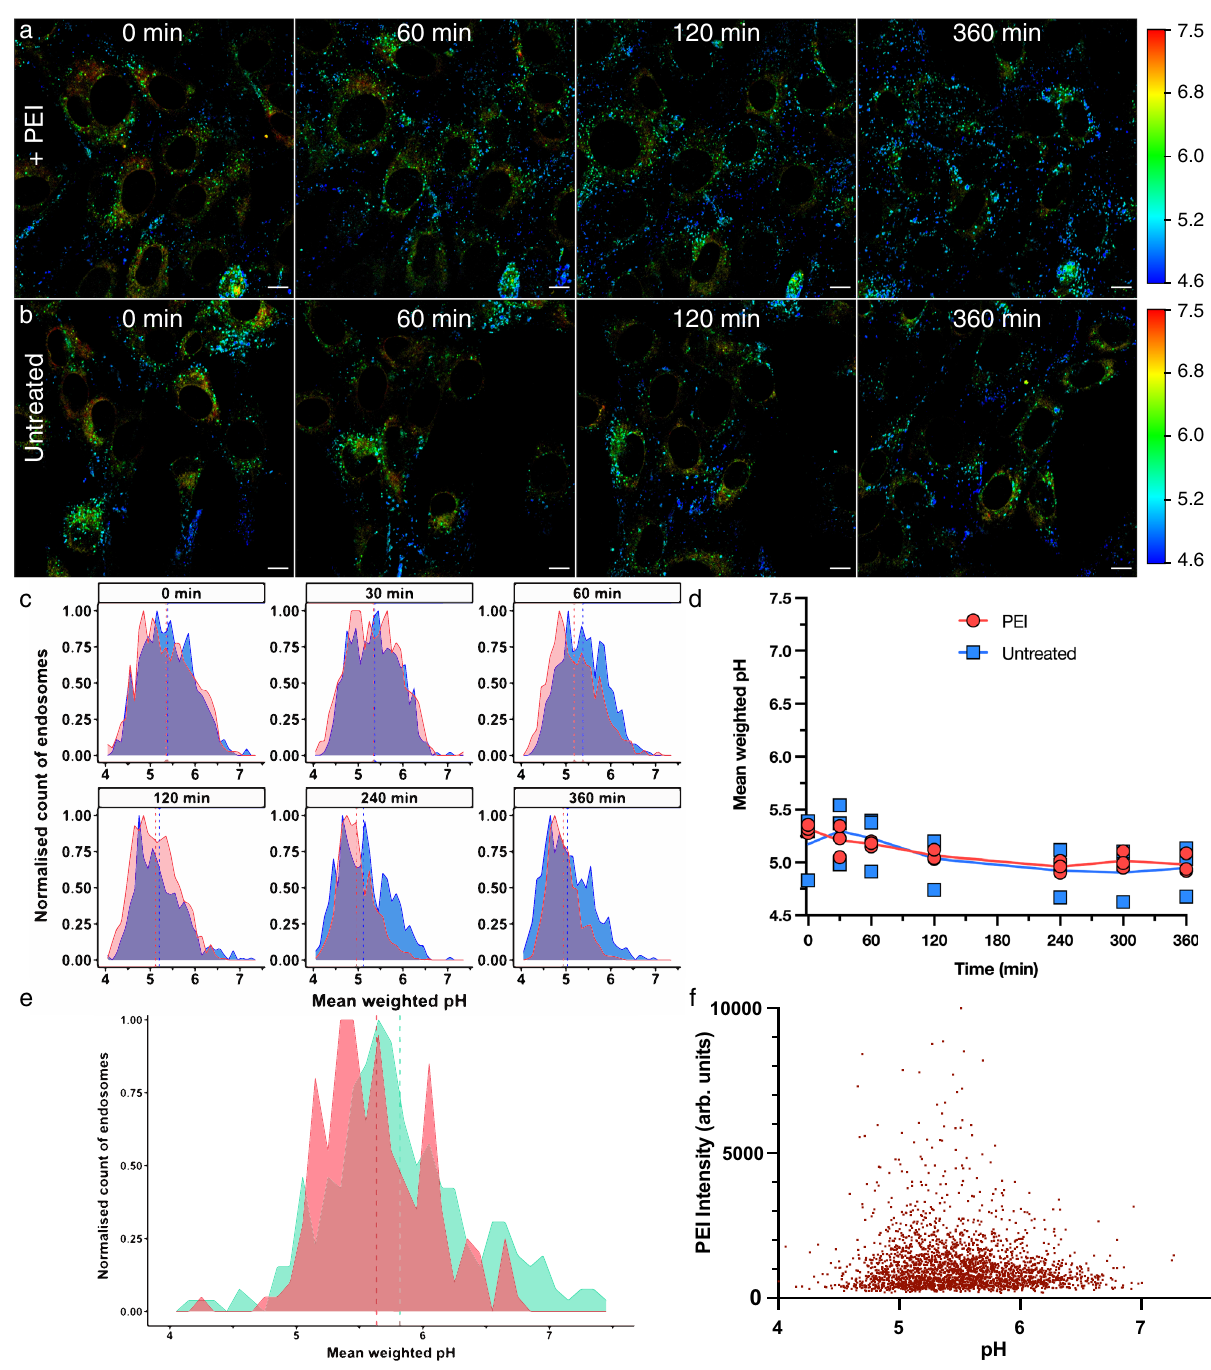
Fig.5|EmployingthemApplepHLIMsensortoprobeforthepurportedproton sponge effect of PEI. a , b Time course FLIM images of NIH-3T3 cells expressing TMEM106b-mApple treated with a 80 µ gmL − 1 PEI or b untreated. Images pseudo coloured by a phasor mask (Fig. 1g), scale bar=10 µ m. c Histograms of untreated (blue),PEItreated (red)atthe indicated timepoints showing the distribution of pH in endo/lysosomal compartments in a single image, with the mean pH shown as a dotted line. d Summary plot of the vesicle pH, untreated (blue squares), PEI (red circles), solid line indicates the mean of three independent replicates ( n =3).